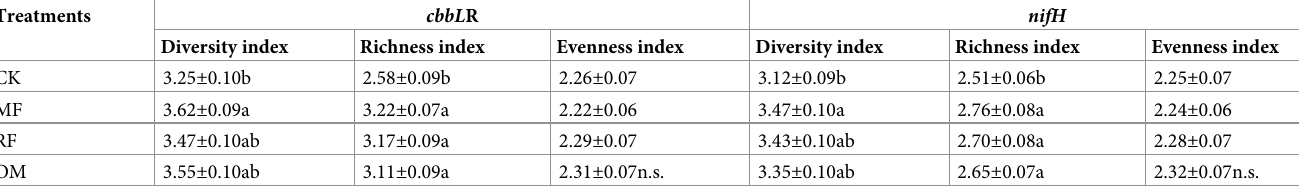
Table 1. Diversity of cbbL R and nifH genes were affected by different long-term fertilizer treatments. Treatments cbbL R nifH Diversity index